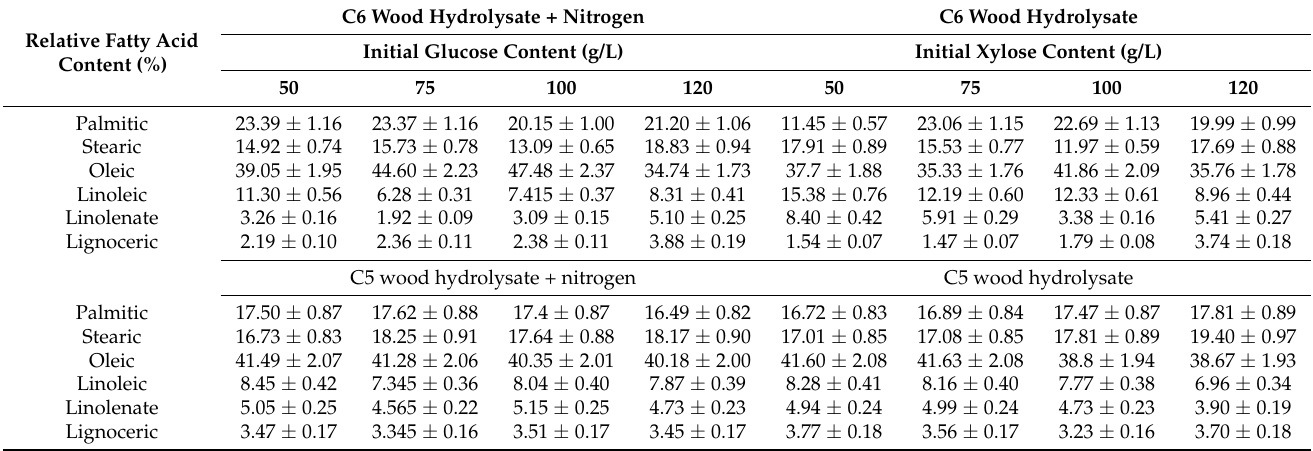
Table 2. Performance of R. toruloides -1588 using C5 and C6 hydrolysates as a culture media.